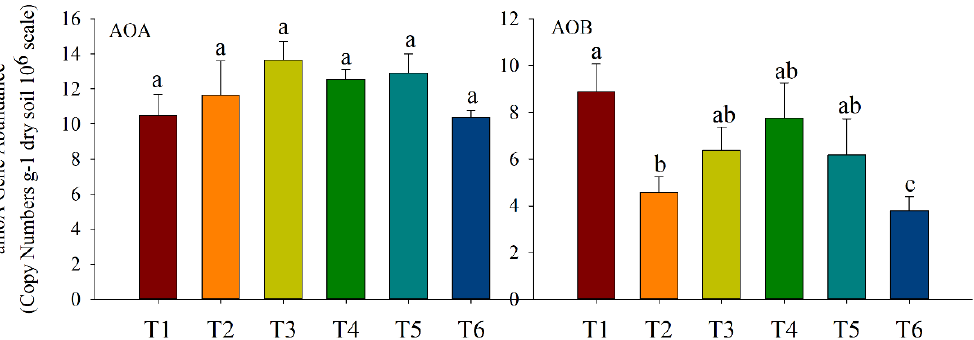
Figure 6. amoA gene copy numbers of AOA and AOB in soil under different substitution ratios. The different uppercase letters indicate significant differences among soil amendments, with error bars that represent the standard deviation ( p < 0.05, Duncan’s multiple-range test). T1: inorganic fertilizer; T2: 50.0% organic fertilizer; T3: 37.5% organic fertilizer; T4: 25.0% organic fertilizer; T5: 12.5% organic fertilizer; T6: no fertilizer.